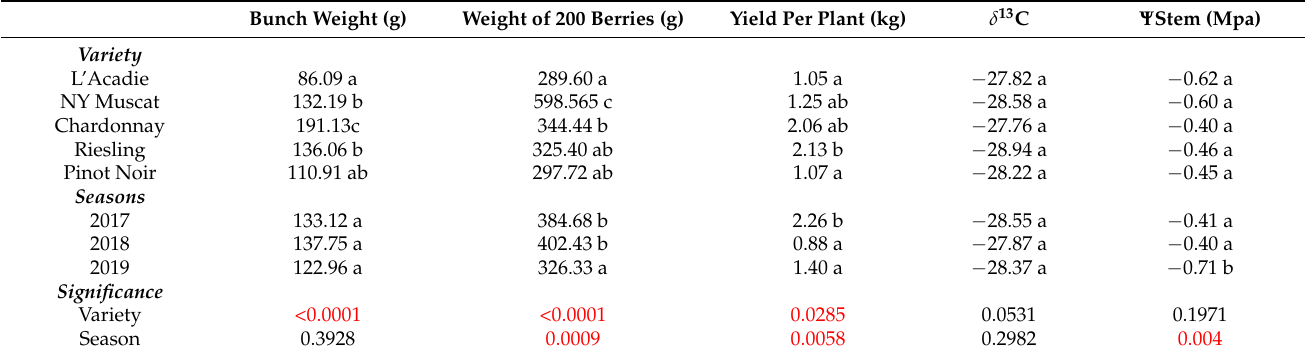
Table 5. Effect of variety on yield, yield components and water status of grapevines growing under cold climate conditions over three consecutive seasons.